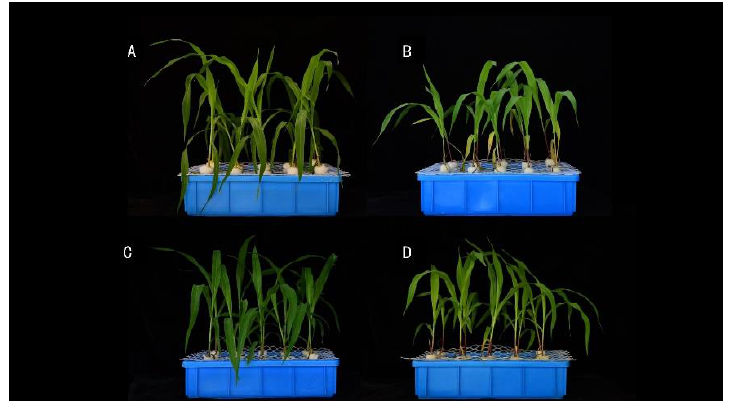
Figure 6. Phenotypic response of maize seedlings under low nitrate (0.04 mM NO 3 − ) and optimal nitrate 4 mM NO 3 − ) conditions with hydroponics. ( A ) Mutant tga under normal nitrogen treatment conditions. ( B ) Mutant tga under low nitrate. ( C ) Wild-type under normal nitrogen treatment conditions. ( D ) Wild type under low nitrogen treatment.